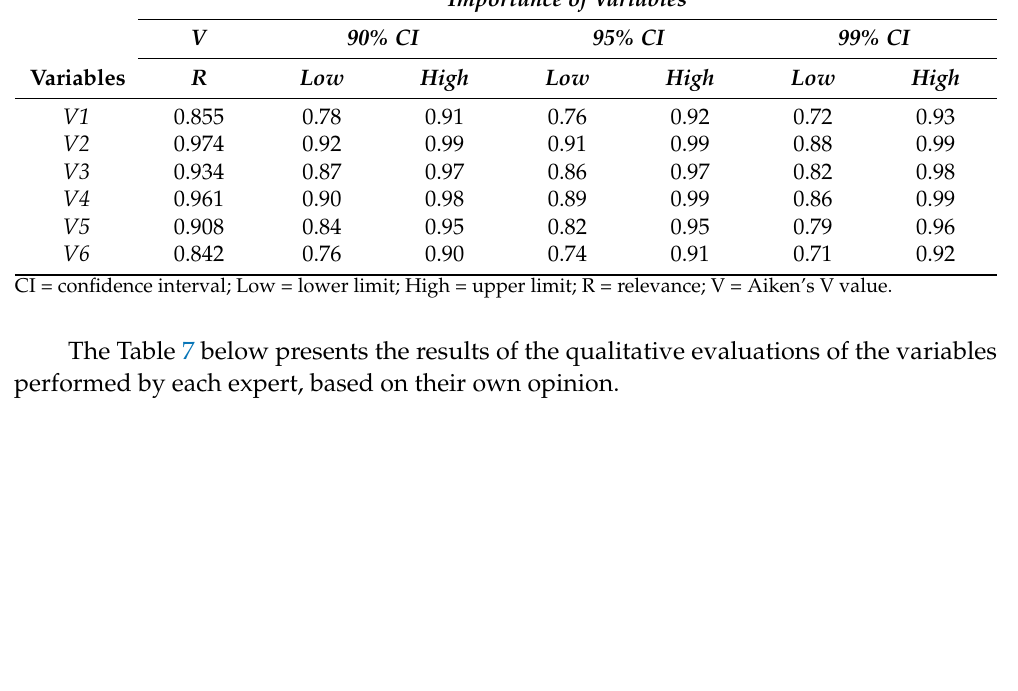
Table 6. Aiken’s V coefficient values and confidence intervals for each of the importance of variables results. Importance of